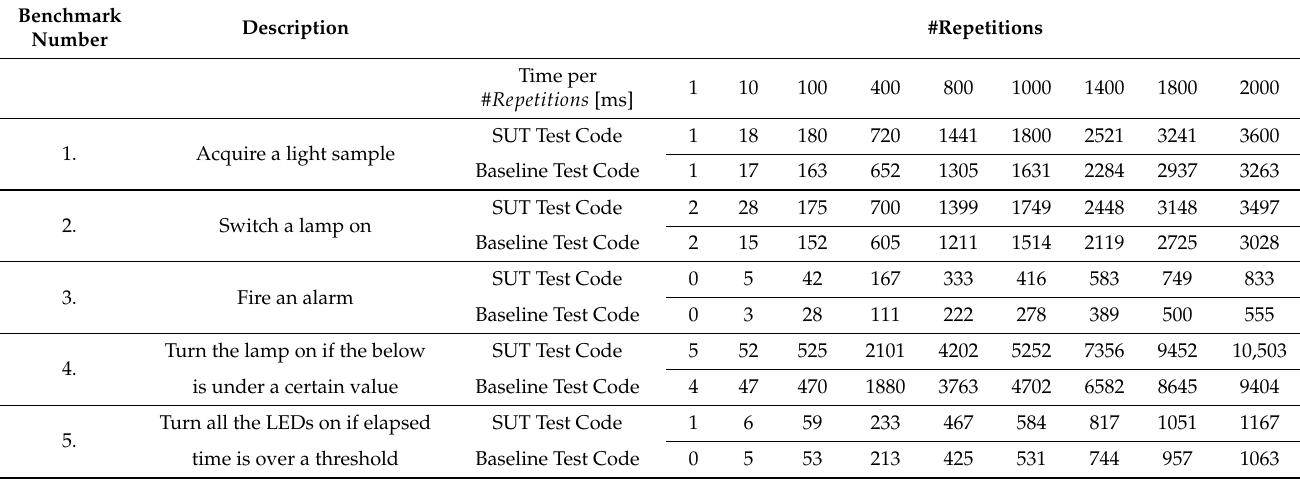
Table 4. Time per repetition [ms] for a set of benchmark SUTs and the respective baseline test code. Benchmark Number